Question: What style of plot is this figure drawn as?
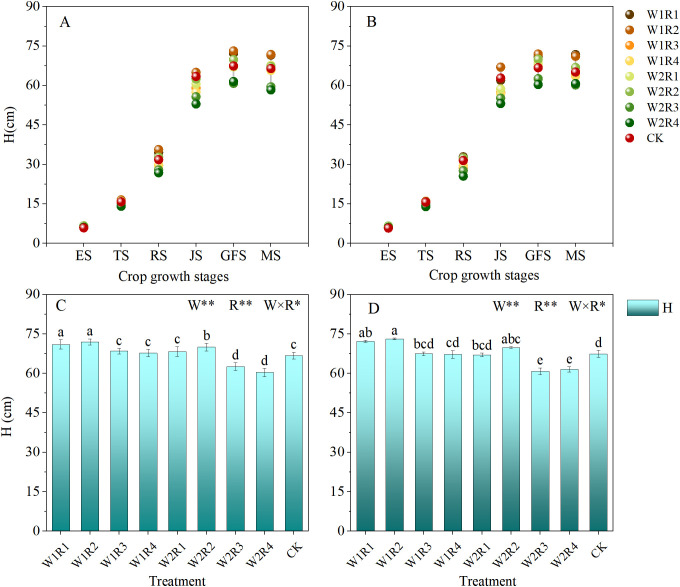
Answer: bar